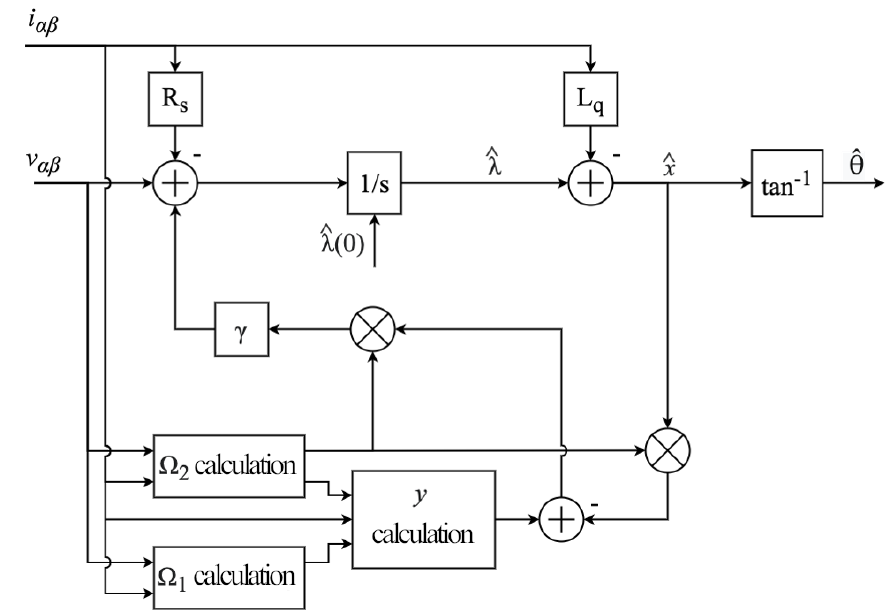
Figure 11. Scheme of the regression RFO sensorless algorithm.